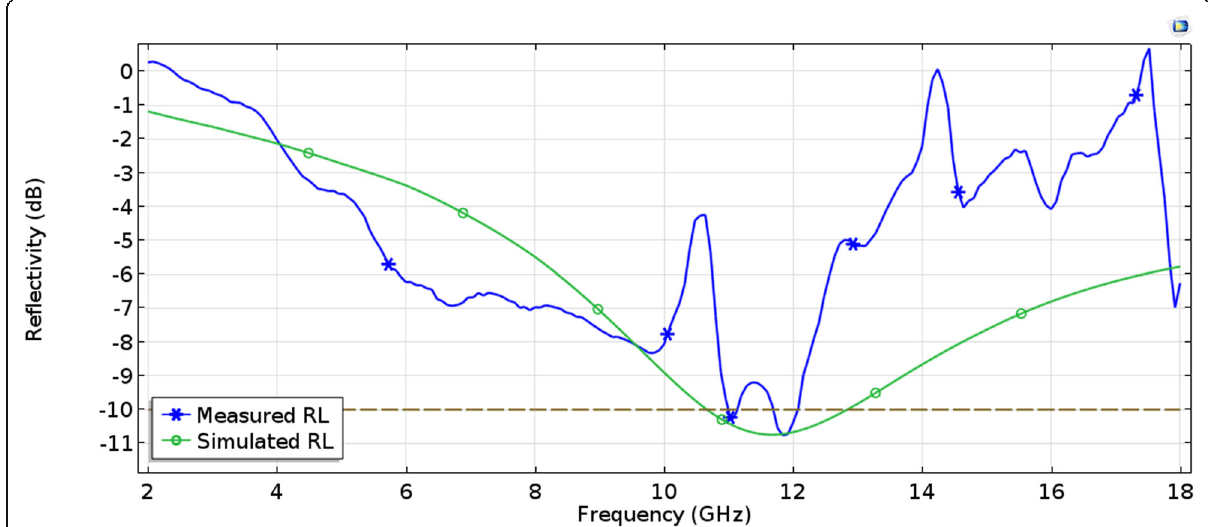
Fig. 7 Measured and simulated reflectivity plots at 10° incidence of TE-polarized wave